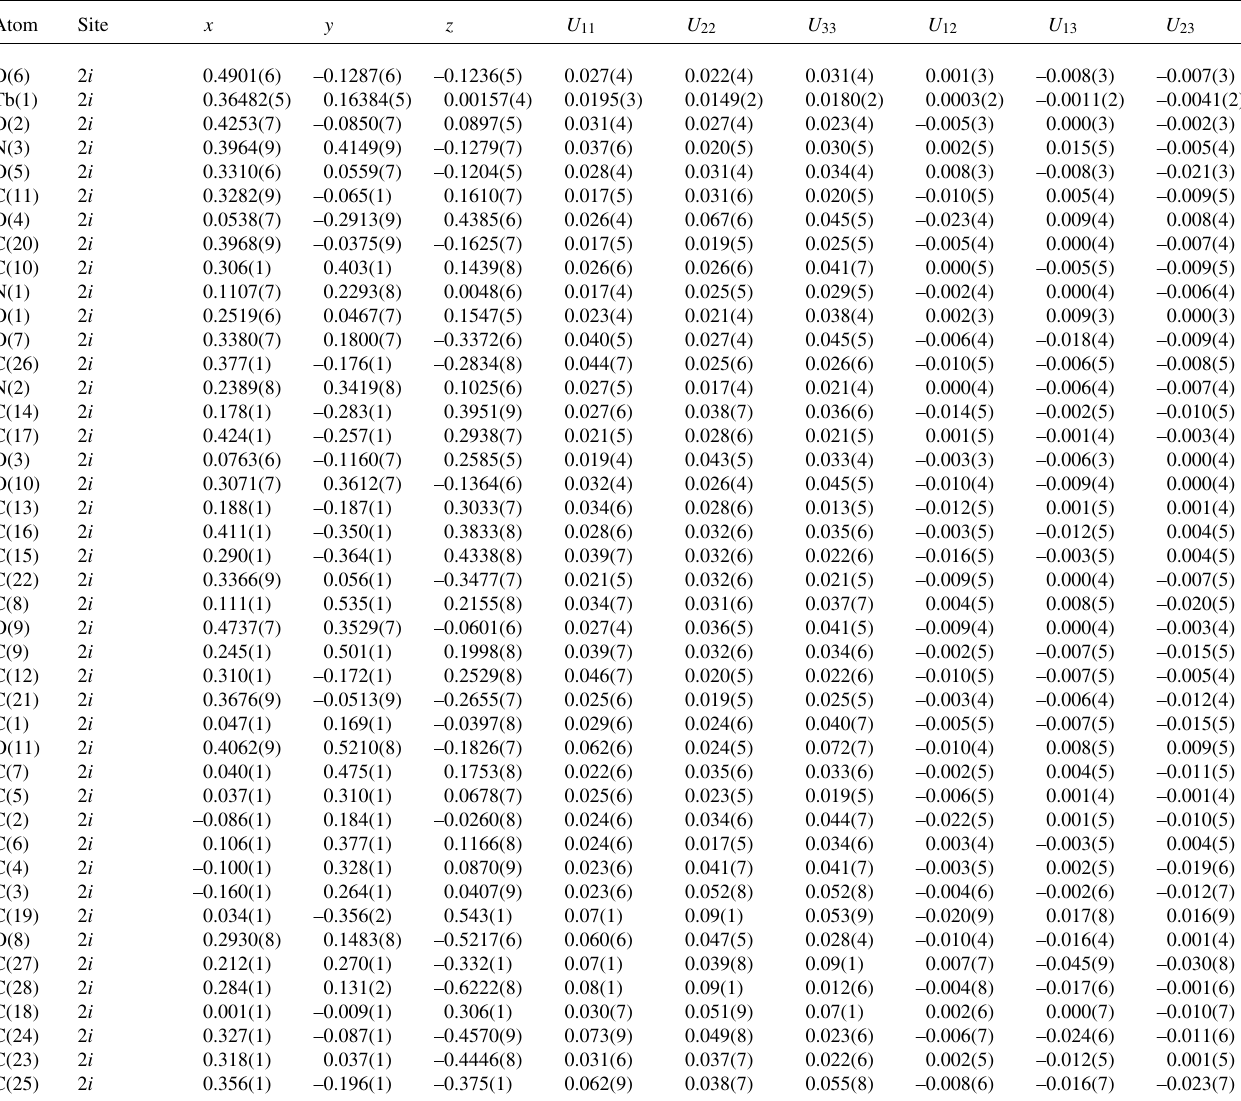
Table 3. Atomic coordinates and displacement parameters (in Å 2 )